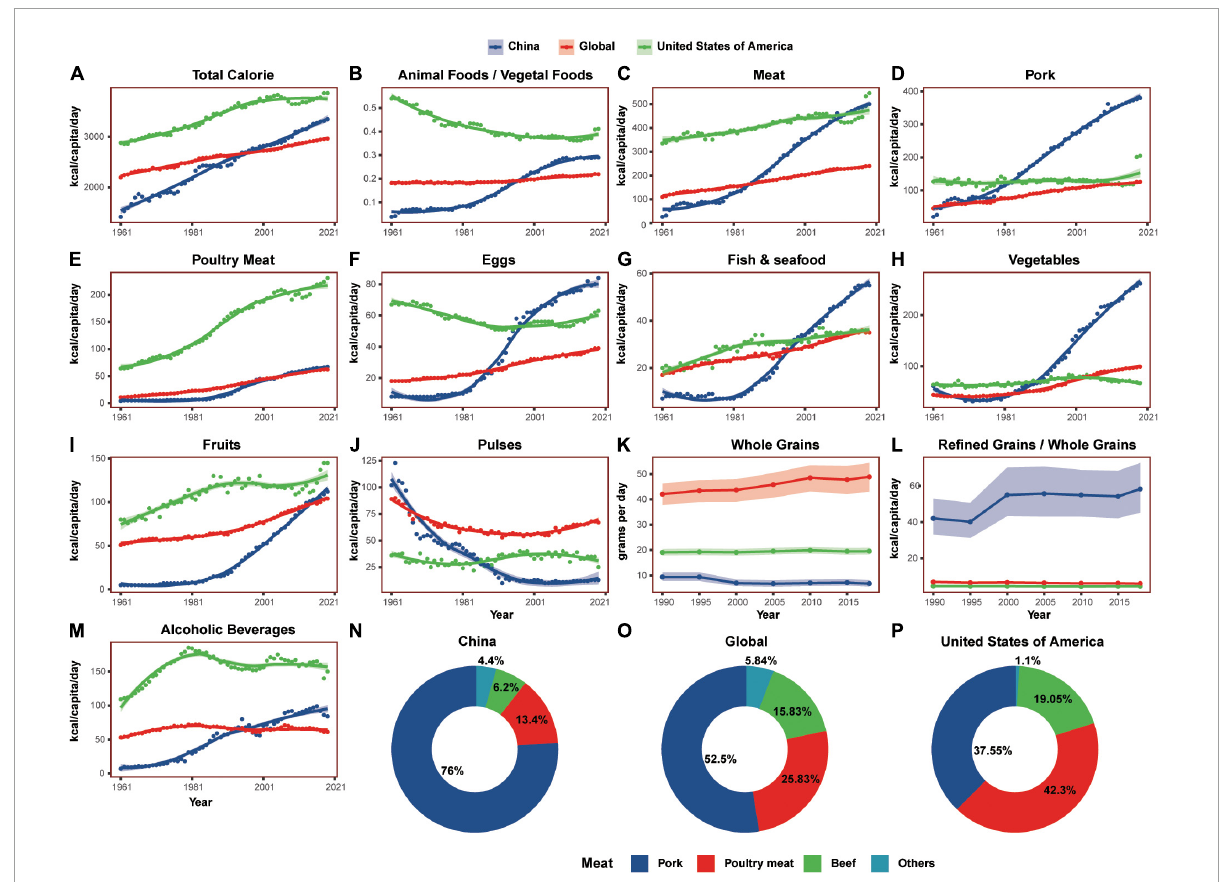
FIGURE7 The diet composition differences between China, the United States of America, and the world during the past six decades. (A,C–K,M) Showed the daily consumption of total calorie, meat, pork, poultry meat, eggs, fish and seafood, vegetables, fruits, pulses, whole grains, and alcoholic beverages, respectively. (B,L) Showed the ratios of animal foods to vegetal foods and refined grains to whole grains, individually. (N–P) Showed the proportion of major meat intake. Shaded sections indicate 95% uncertainty